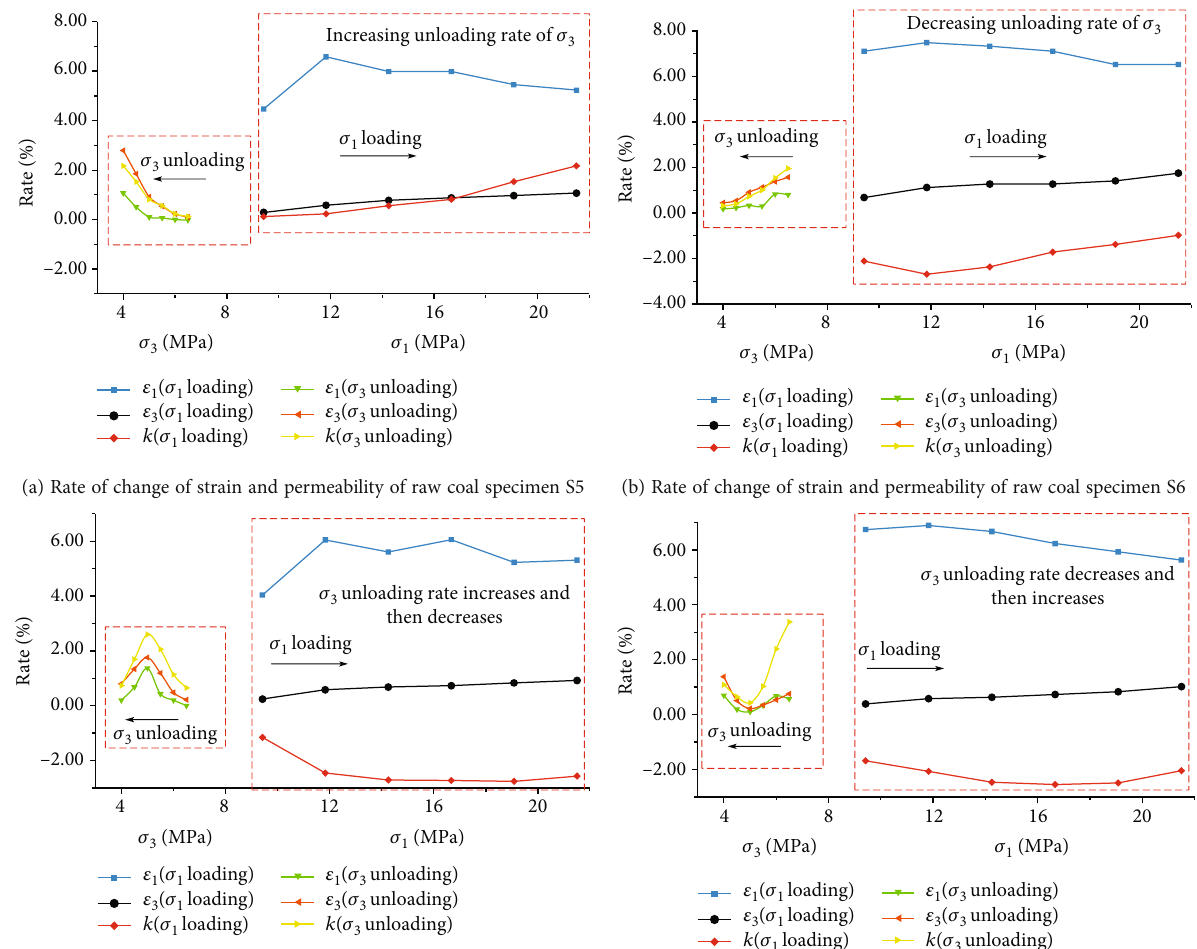
Figure 7: Rate of change of strain and permeability of raw coal under variable con fi ning pressure unloading